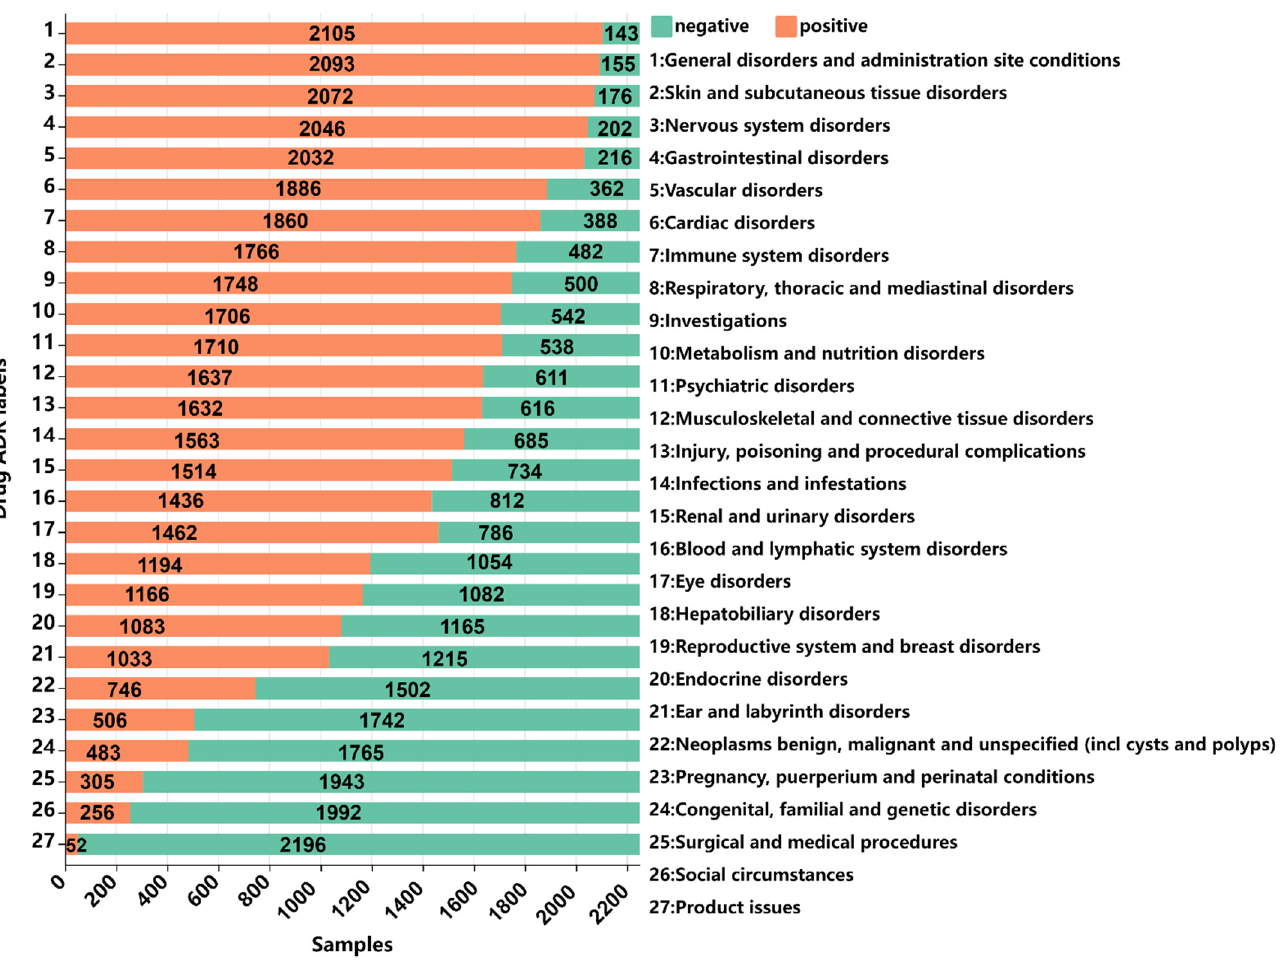
Figure 5. Sample distribution plot: horizontal axis represents the sample size, vertical axis represents the 27 ADR labels; represents positive samples, while is negative samples.